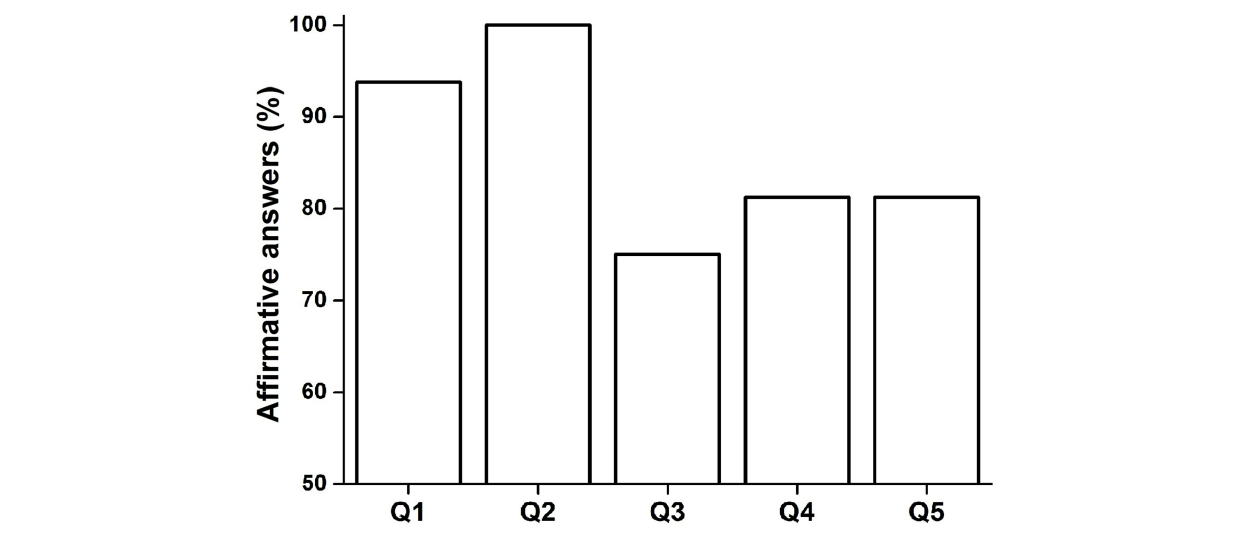
Figure 4. Results from the questionnaire on the usability of COGNI-TRAcK. The columns show the percentages obtained in the first 5 questions referring to usability and motivation.